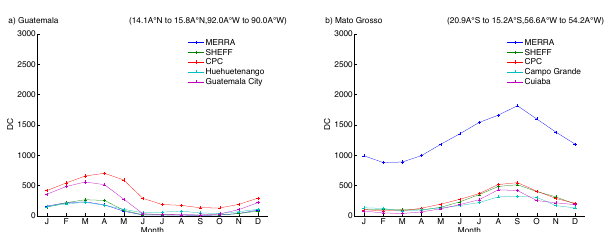
Figure 3. Monthly mean DC for Guatemala and the Mato Grosso of Brazil. MERRA, SHEFF and CPC DC are from the GFWED gridded fields over the latitude and longitude range specified in the caption. The other two DC plots are for representative weather sta- tions in that range.